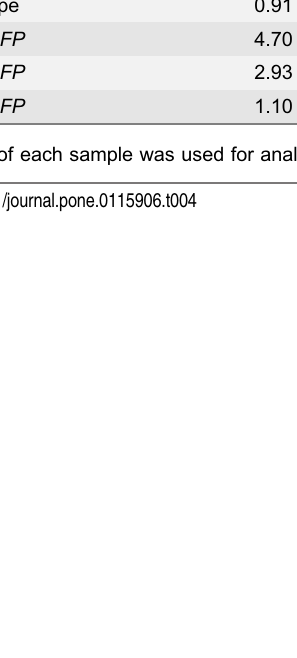
Table 4. Hydroxyproline, Tyr, Idt, and di-Idt amount in different cell walls. Cell wall type